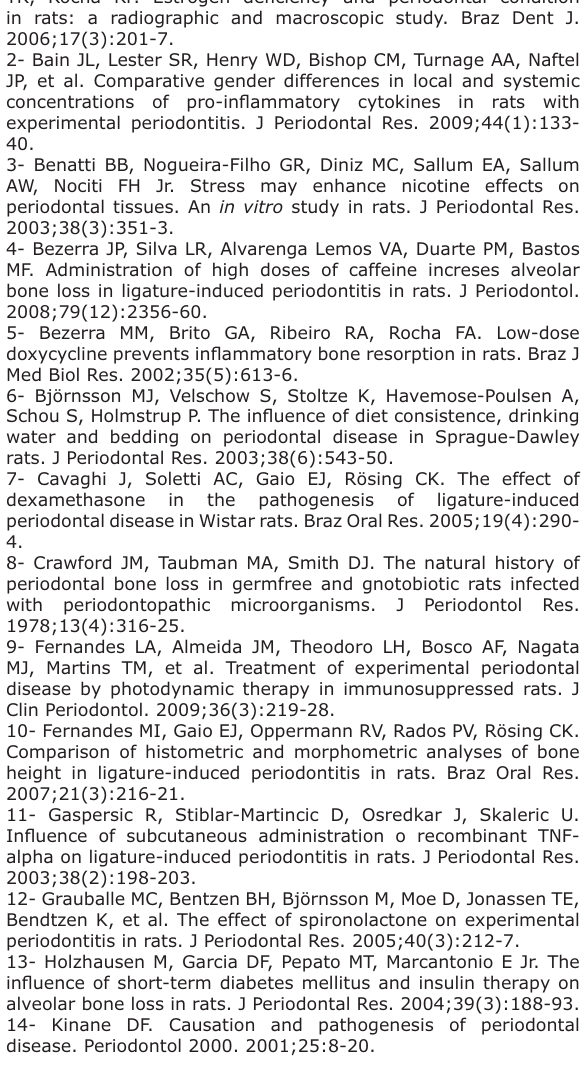
* independent sample t test (p<0,05). Lower case letters** should be considered in the area method column and capital letters *** should be considered in the distance method column (ANOVA and Tukey, p< 0.05). Means followed by different letters differ